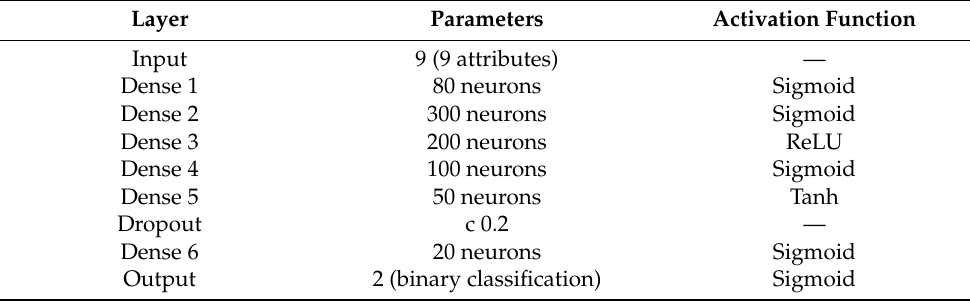
Table 8. Architecture of NN2 model in the second experiment.